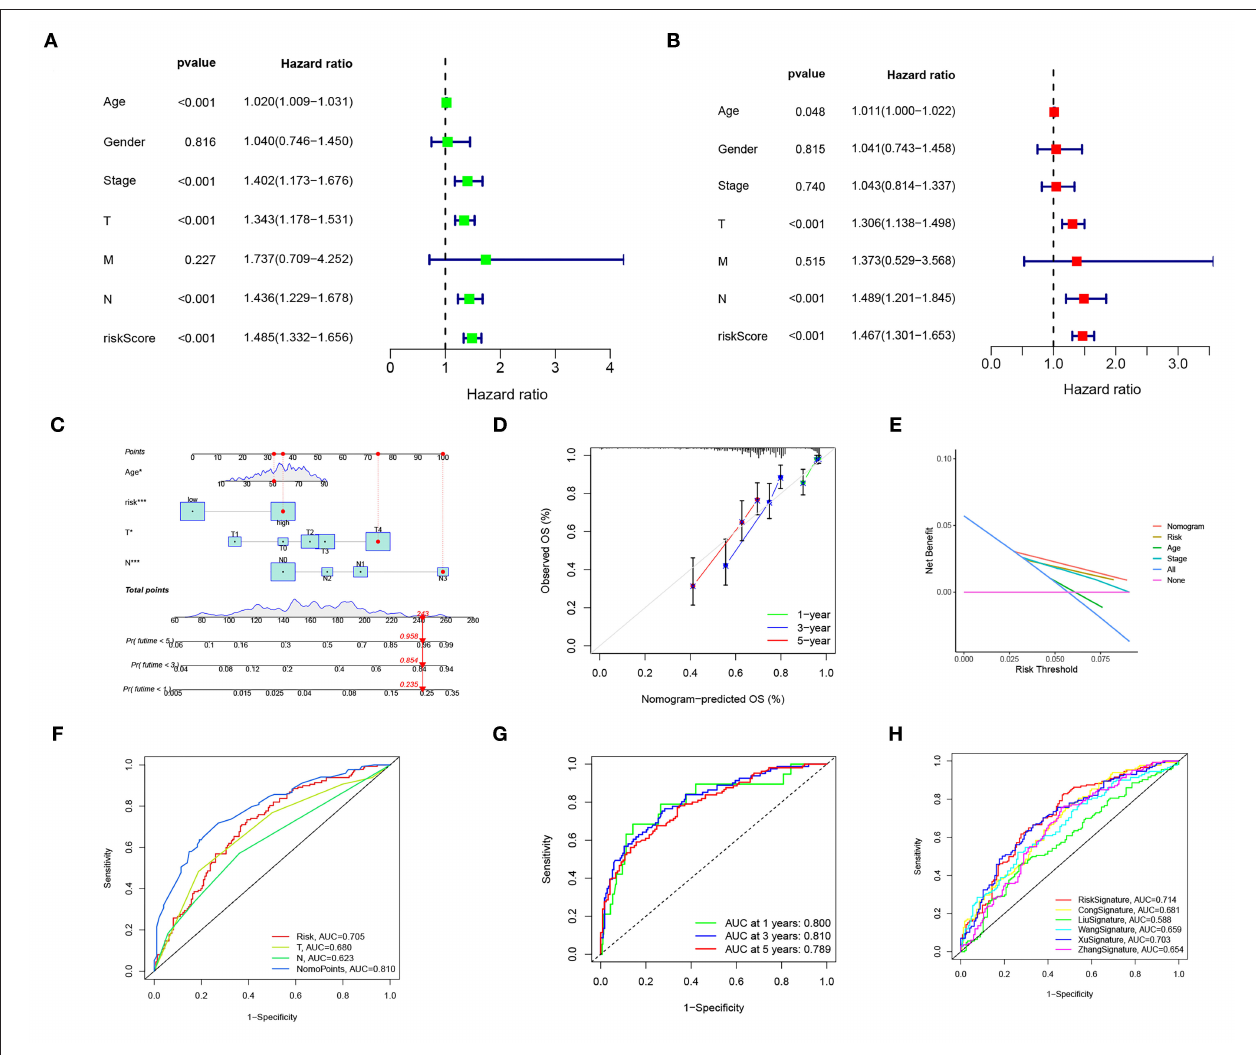
FIGURE 5 | The risk score and nomogram have independent prognostic values. (A) Univariate Cox regression analyses of OS in the entire TCGA cohort. (B) Multivariate Cox regression analyses of OS in the entire TCGA cohort. (C) The nomogram, including clinical features and the risk score, for predicting outcomes in patients with CM. (D) The calibration curve analysis showed that the actual and the predicted 1-, 3-, 5-year survival times were consistent compared with the reference line. (E) A decision curve showed net benefits for patients with CM. (F,G) ROC curves for the nomopoints, risk scores, and clinical features. (H) ROC curves for the risk score and existing CM